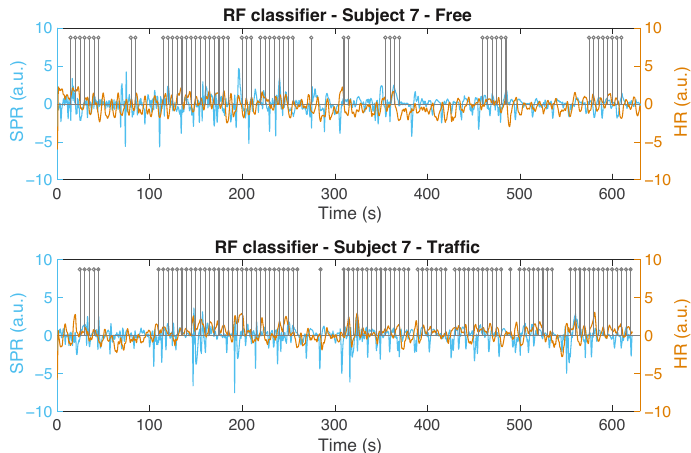
Figure 11. The output of the RF classifier for Subject 7 in both scenarios: without traffic ( top ) and with traffic ( bottom ).